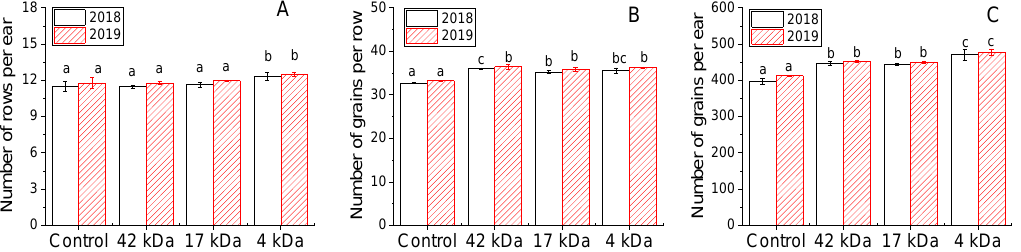
Figure 6. Influence of MWs on number of rows per ear ( A ) and number of grains per row ( B ) and number of grains per ear ( C ) collected in 2018 and 2019. Bars represent mean values of three replicates ± standard deviation. Different letters indicate significant differences ( p < 0.05).